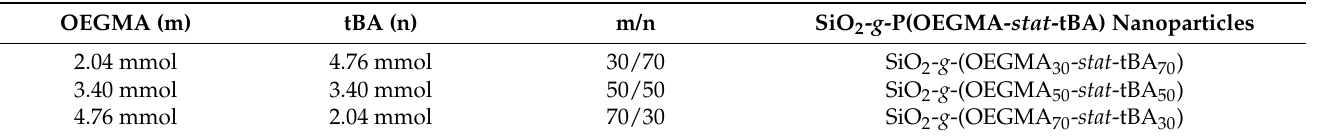
Table 1. Ratio of OEGMA and tBA monomers for preparation of SiO 2 - g -P(OEGMA- stat -tBA)